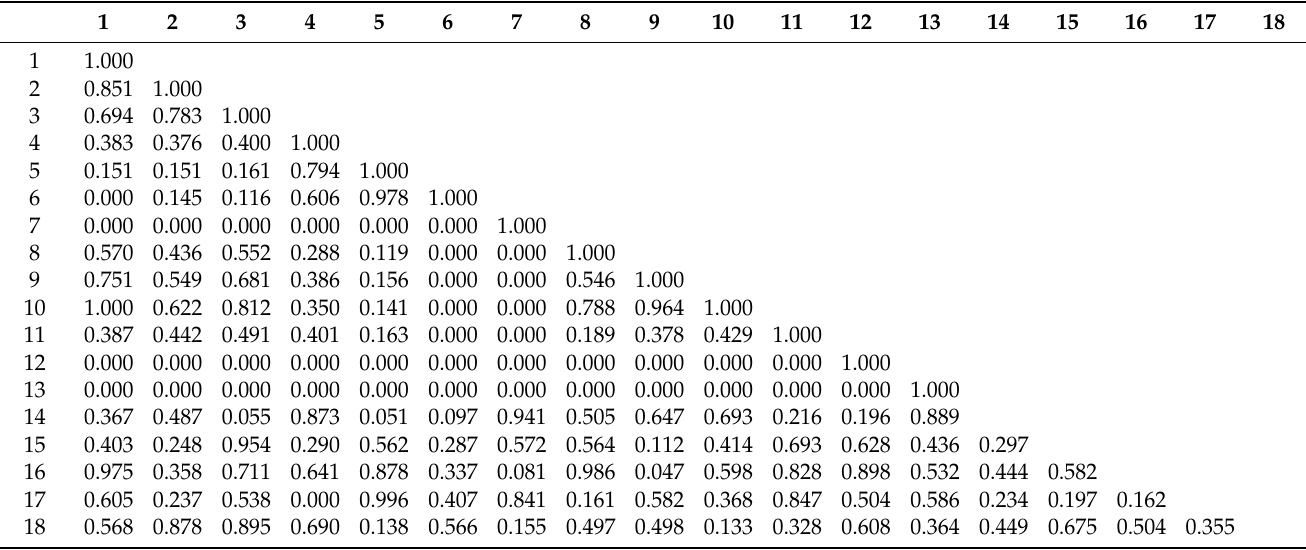
Table A2. A part of the data of the equity relationship of the generators.